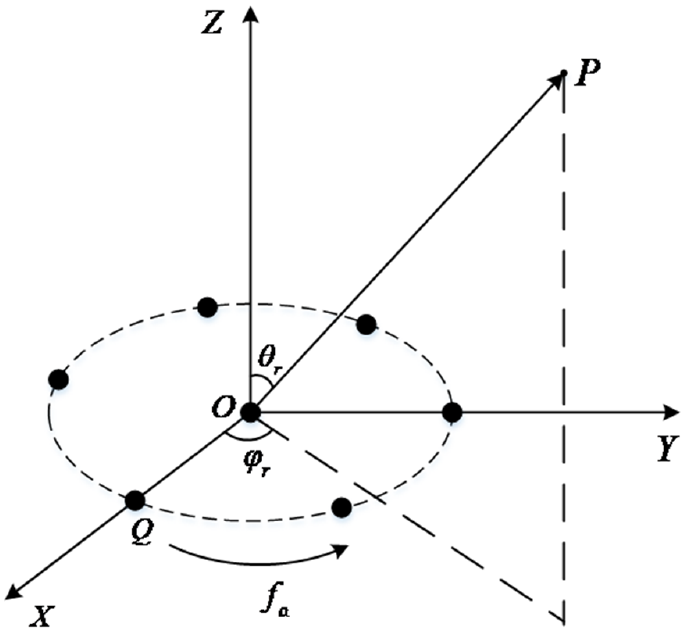
Figure 1. Diagram of radar configuration. Suppose that there exists a cone-shaped target in space. In addition to spinning around its axis of symmetry to keep stationary while going on a translation along the radar LOS, the cone-shaped target will undergo a coning motion about the radar LOS with the angular velocity 2 π f c n LOS . The spinning and the coning make up precession, and the precession angle is θ c . The geometry relationship of the precession cone-shaped target is shown in Figure 2. The height of the cone-shaped target is H , the radius of the cone bottom is r c , and the height from the center of mass O (cid:48) to the cone bottom is h . The spherical coordinate of O (cid:48) is ( R 0 , θ r , ϕ r ) , where R 0 denotes the radial distance from O (cid:48) to O . Assume that the target is a smooth cone. Therefore, the influence of spinning motion on radar echoes can be ignored according to its rotation symmetry. At this point, the precession of the cone-shaped target can be regarded as a scatterer rotating around the radar LOS with the angular velocity 2 π f c n LOS and radius r